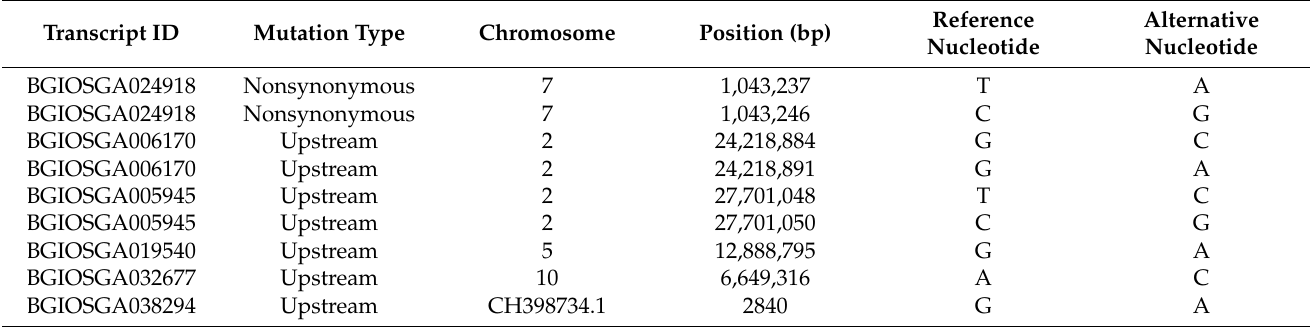
Figure 6. The distribution of ∆ (All − index) on the chromosomes of two F 2 populations. The x − axis indicates chromosome length (Mb) and the y-axis indicates ∆ (All − index). Table 2. Candidate Gene Information in SR86 and 9311